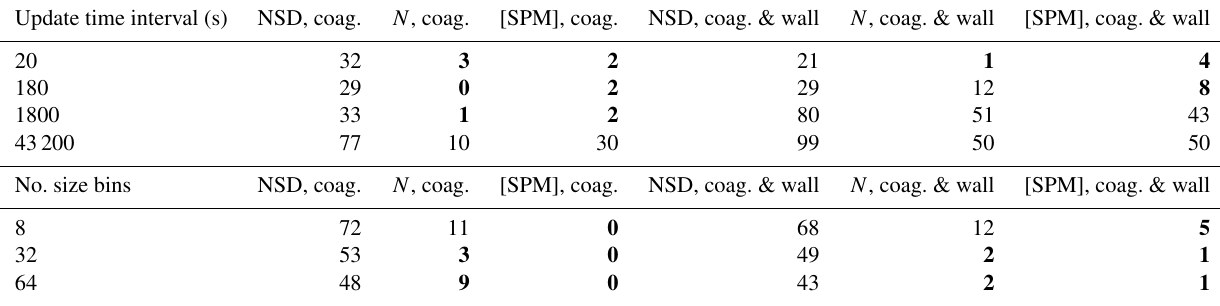
Table 3. Percent deviation from the high-resolution reference case for the seed with partitioning scenario. Condensation occurs due to the Table 2, the concentration of secondary particulate matter ([SPM]) is also evaluated here using Eq. (20). Update time interval